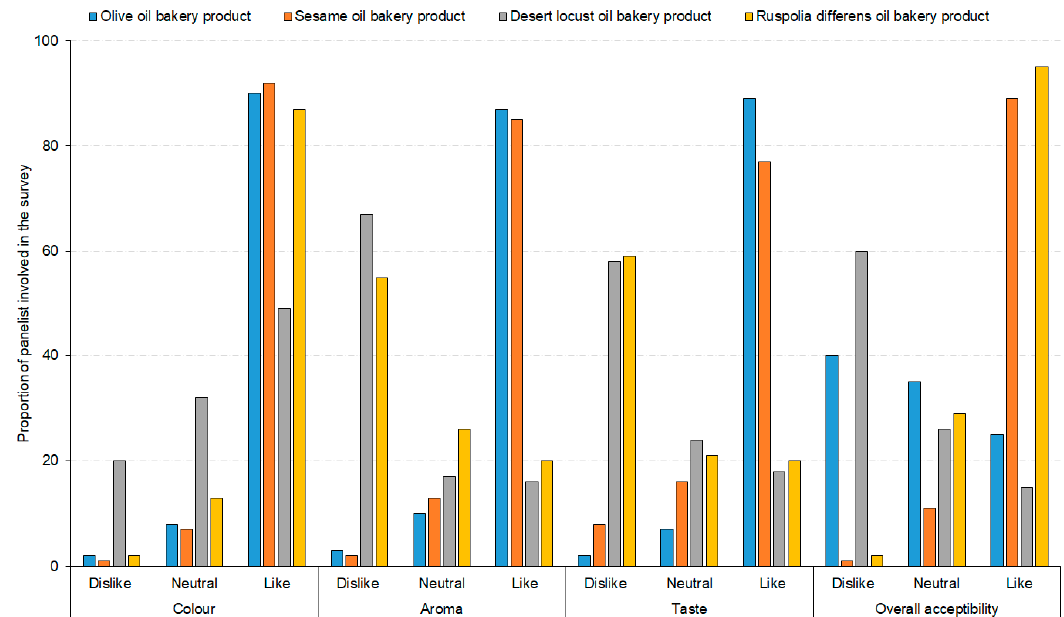
Figure 9. Proportion of panelists preference for color, aroma, taste, and overall acceptability of cookies fortified with insect-based oils.